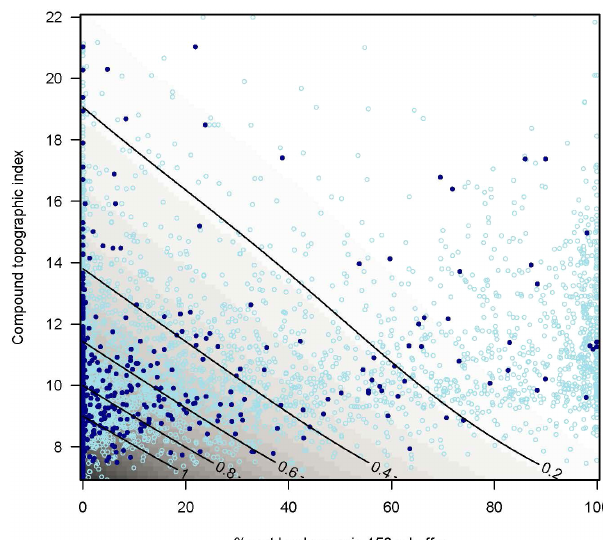
Fig. 3 . Predicted density (males/ha) as a function of wetness in 150-m buffers centered around survey locations and compound topographic index (CTI) at 100-m resolution. Darker shades correspond to higher density, and contours indicate equal density (males/ha) values. Points show the distribution of survey locations with (filled) and without (open) Canada Warbler